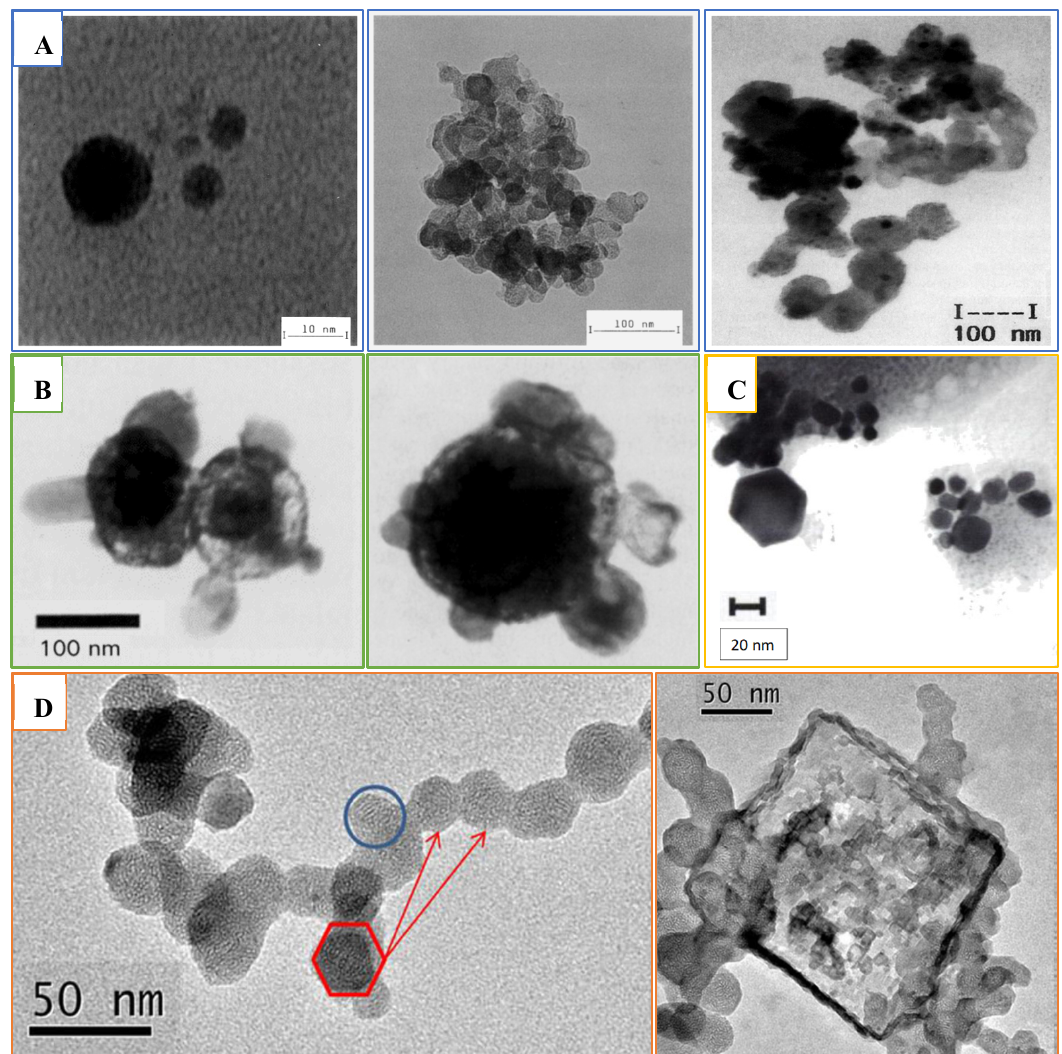
Figure 6. Technegas particle transmission electron microscopy images as obtained through the years using di ff erent techniques or methods. ( A ) Primary particles (left), agglomerate (middle), and particles in the gas stream (right) [18,19]; ( B ) particles in the gas stream (left and right) [20]; ( C ) cluster of particles precipitated in liquid. Reprinted/adapted from [7]; ( D ) primary hexagonal particles agglomerated in clusters (left, red hexagon and red arrows) and NaCl crystals in aerosolized nanoparticles (right) [21]. Reprinted/adapted with permission from Ref. [18–21]; 1993, 1994, 1995, 2021, Springer Nature.